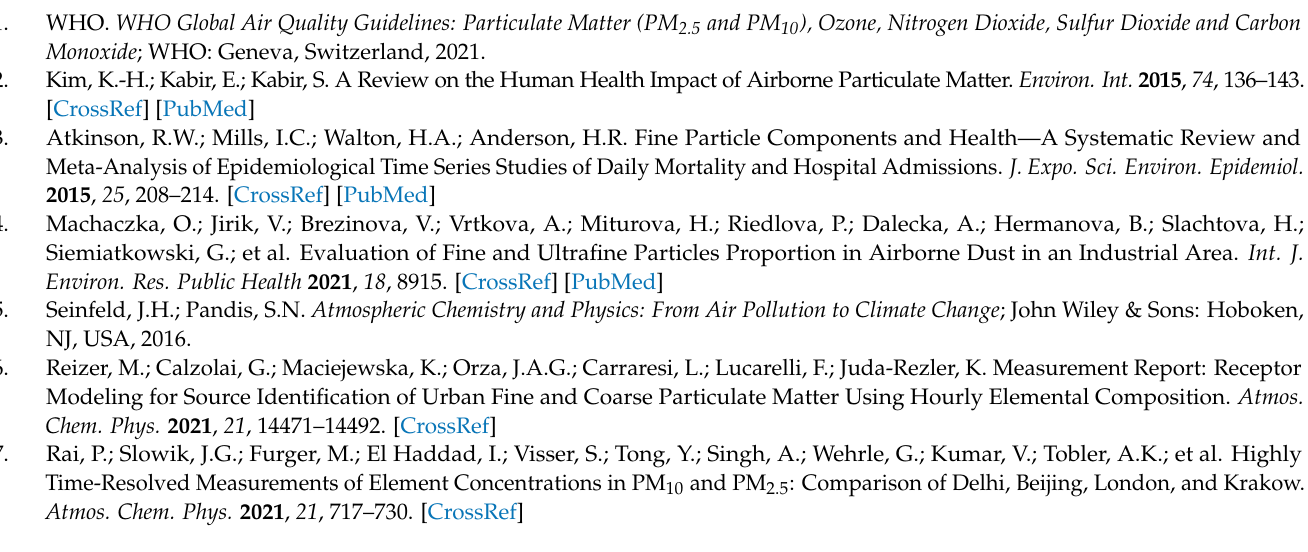
Figure S6: Study area; Figure S7: 72 h back-trajectory calculations arriving at 500 m altitude at the sampling site respectively on 20 April and 21 April at 08:00